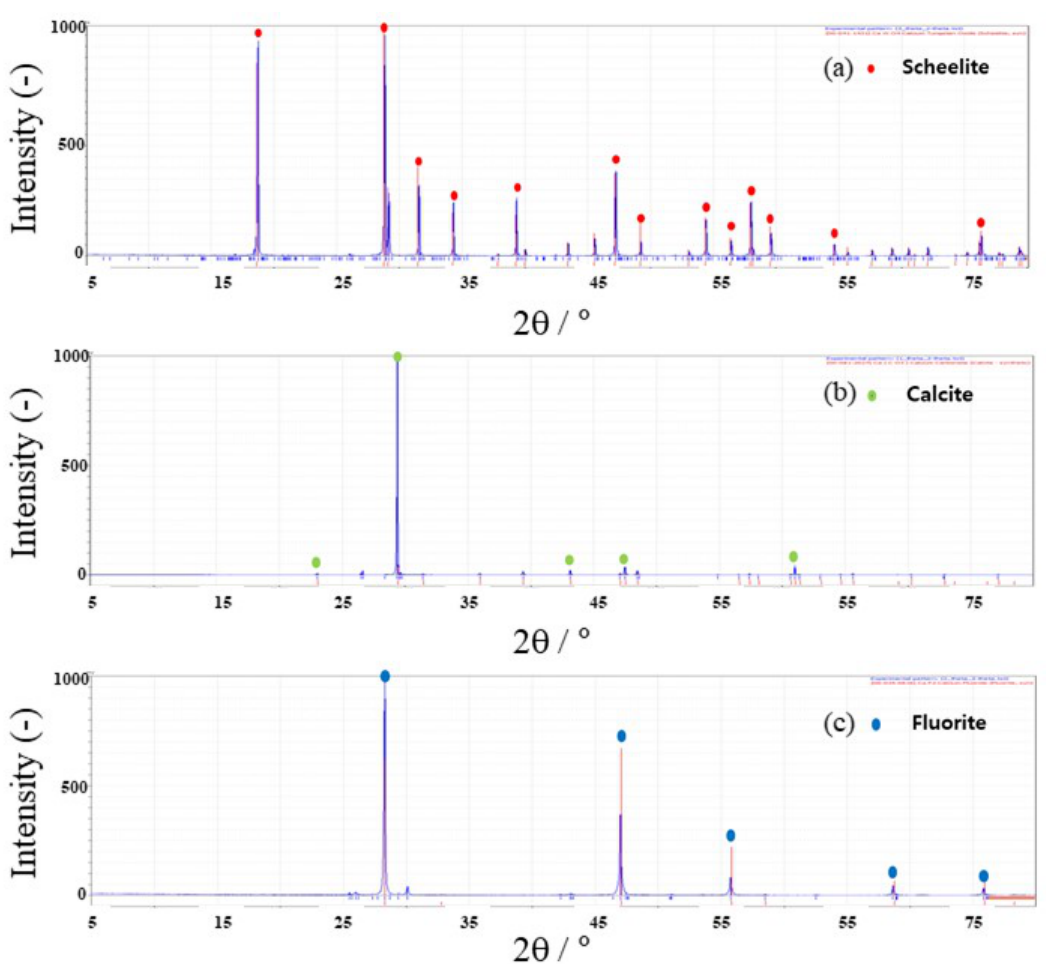
Figure 1. X-ray di ff raction (XRD) analysis results for Ca-bearing minerals: ( a ) scheelite (CaWO 4 ), ( b ) calcite (CaCO 3 ), and ( c ) fluorite (CaF 2